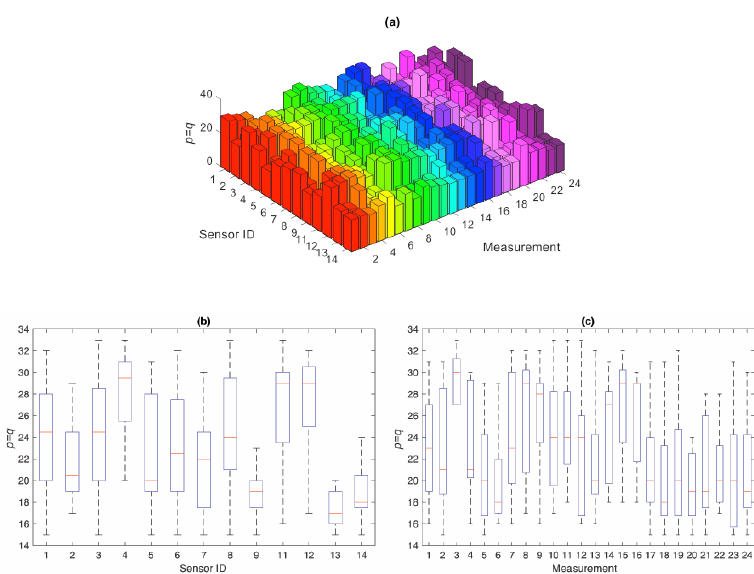
Figure 2. ( a ) Estimated orders p = q of the ARMA model at each sensor location for the normal condition; box plots of the estimated orders as a function ( b ) of sensor position and ( c ) measurement.